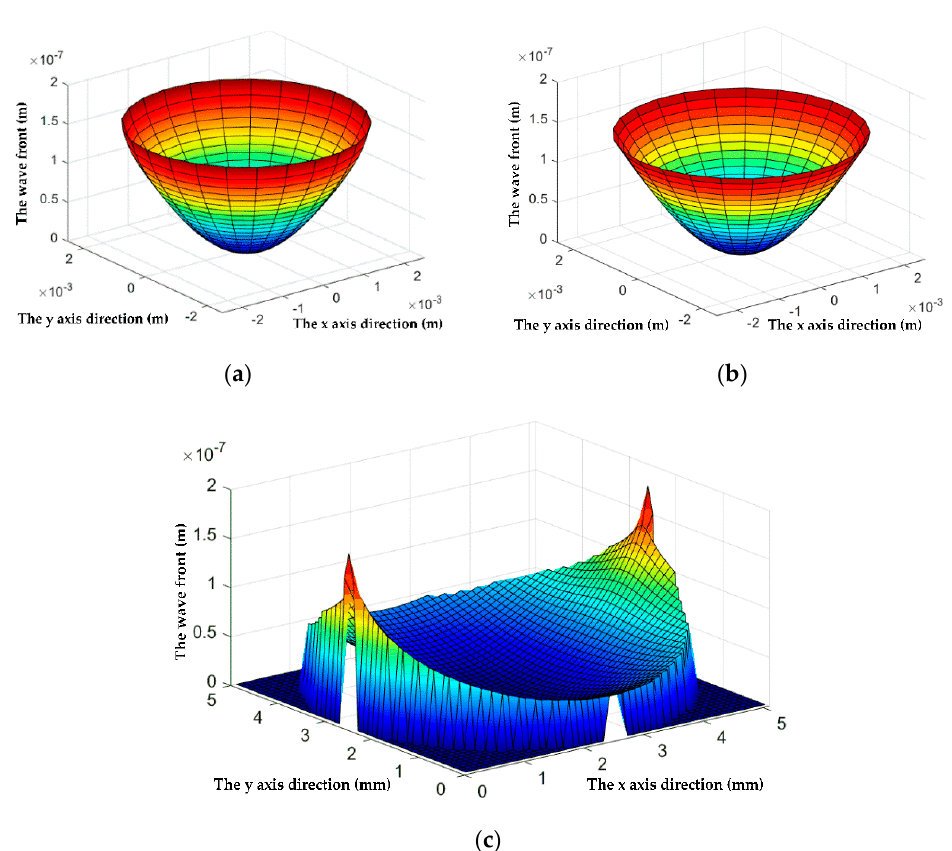
Figure 13. The wave-fronts after a planar wave passed through the laser rods in the ( a ) segmented, ( b ) liquid-cooling, and ( c ) compensated schemes.